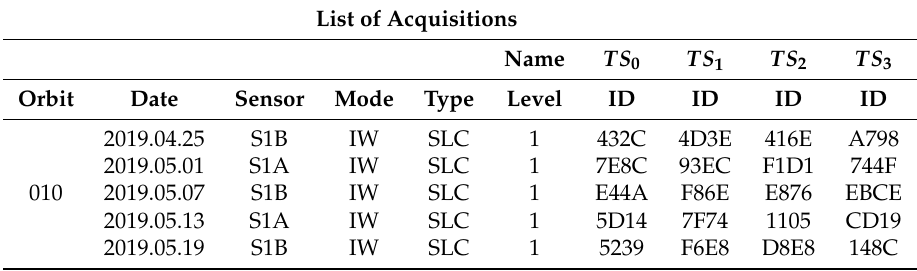
Table A1. Ancillary information about the Sentinel-1 acquisitions selected for the 12 short-time-series. List of